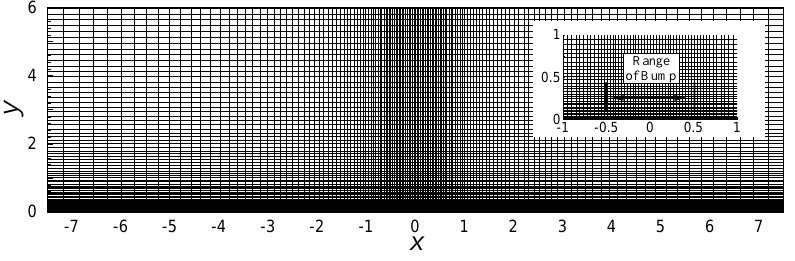
Fig. 2. Baseline grid.